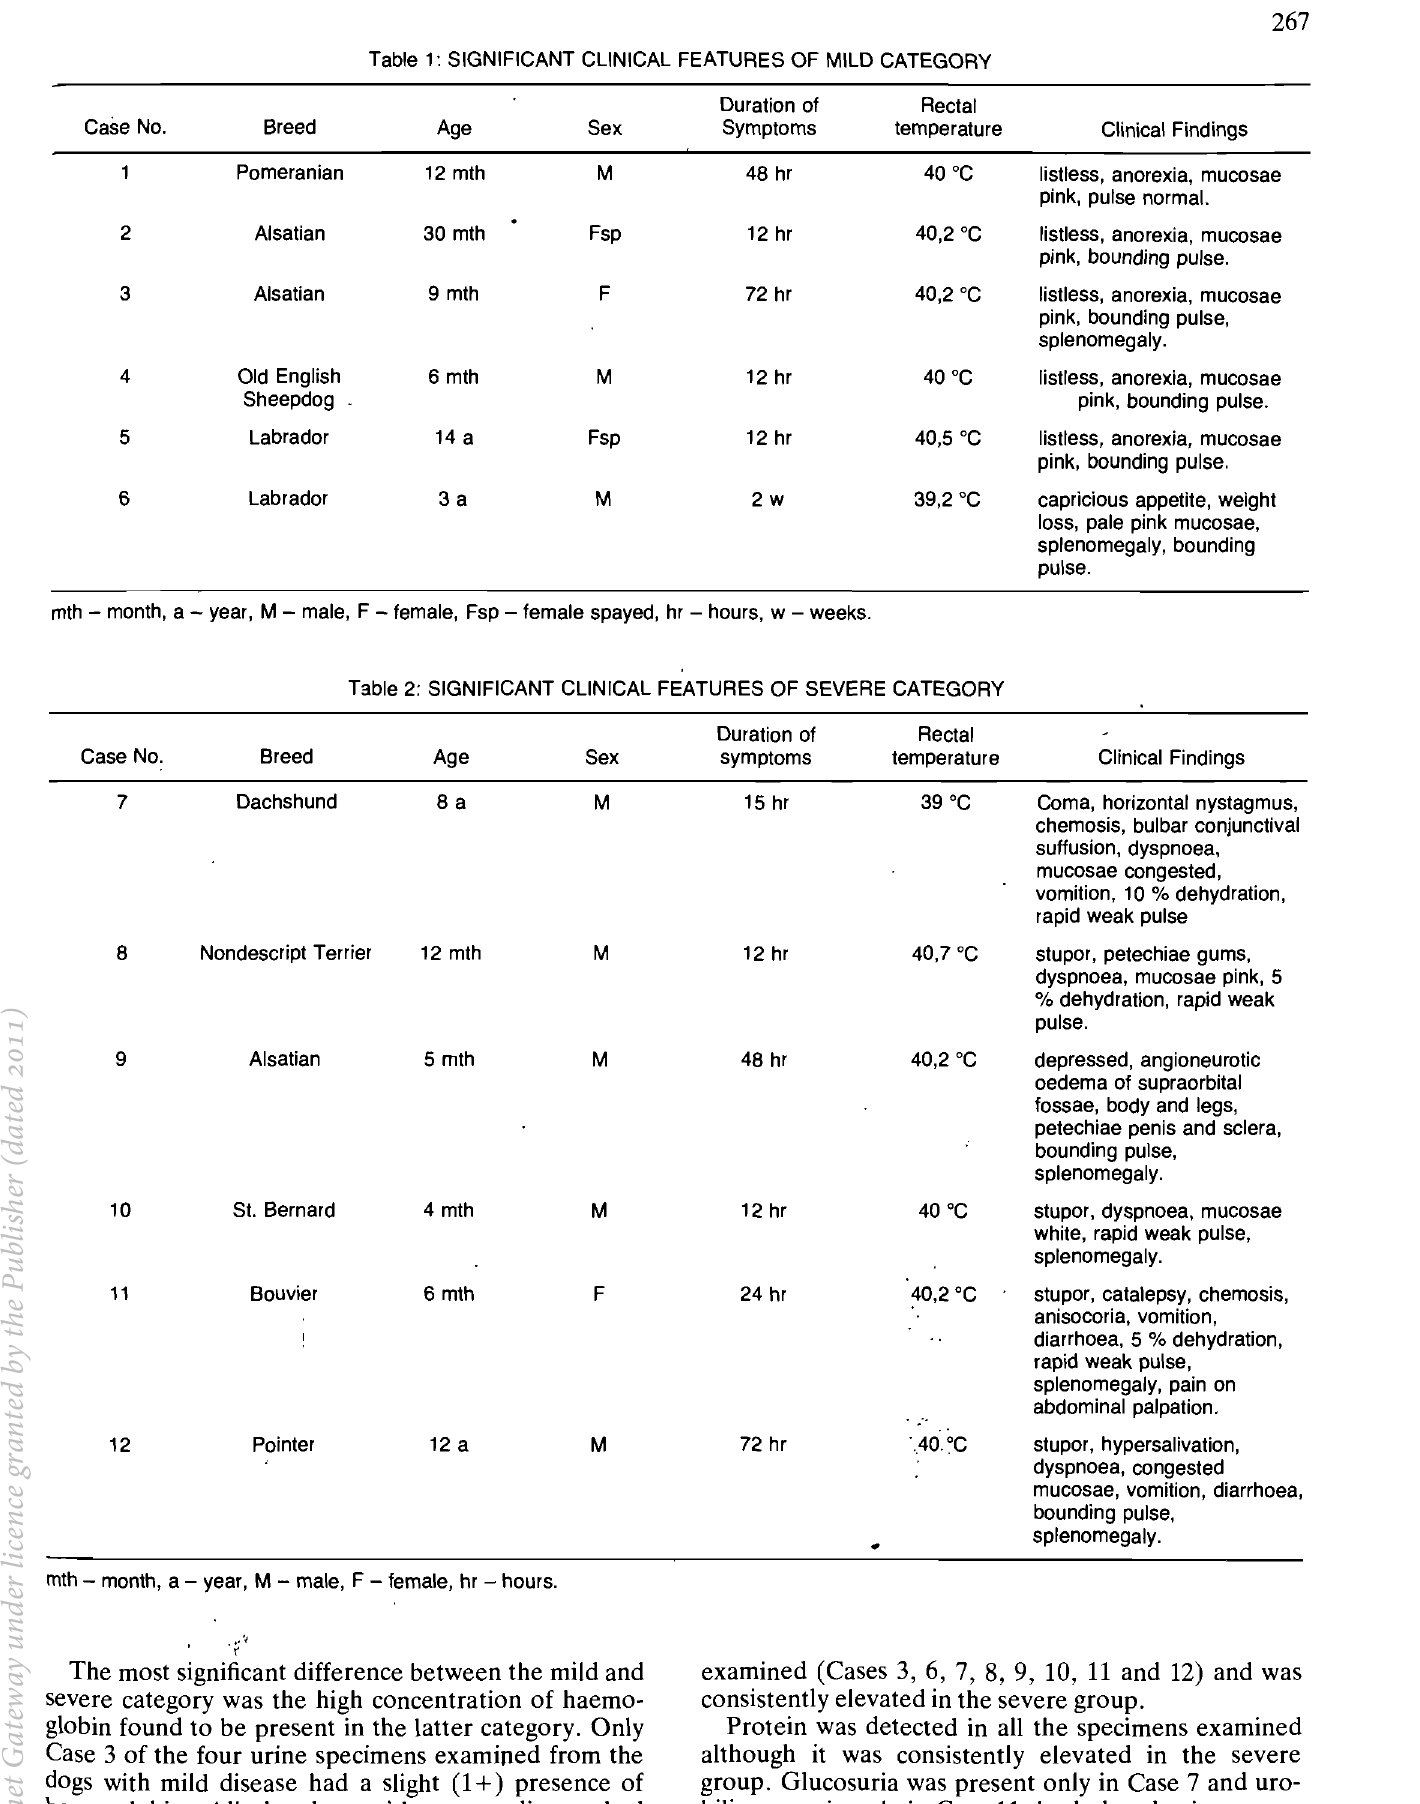
Table 1: SIGNIFICANT CLINICAL FEATURES OF MILD CATEGORY Case No.